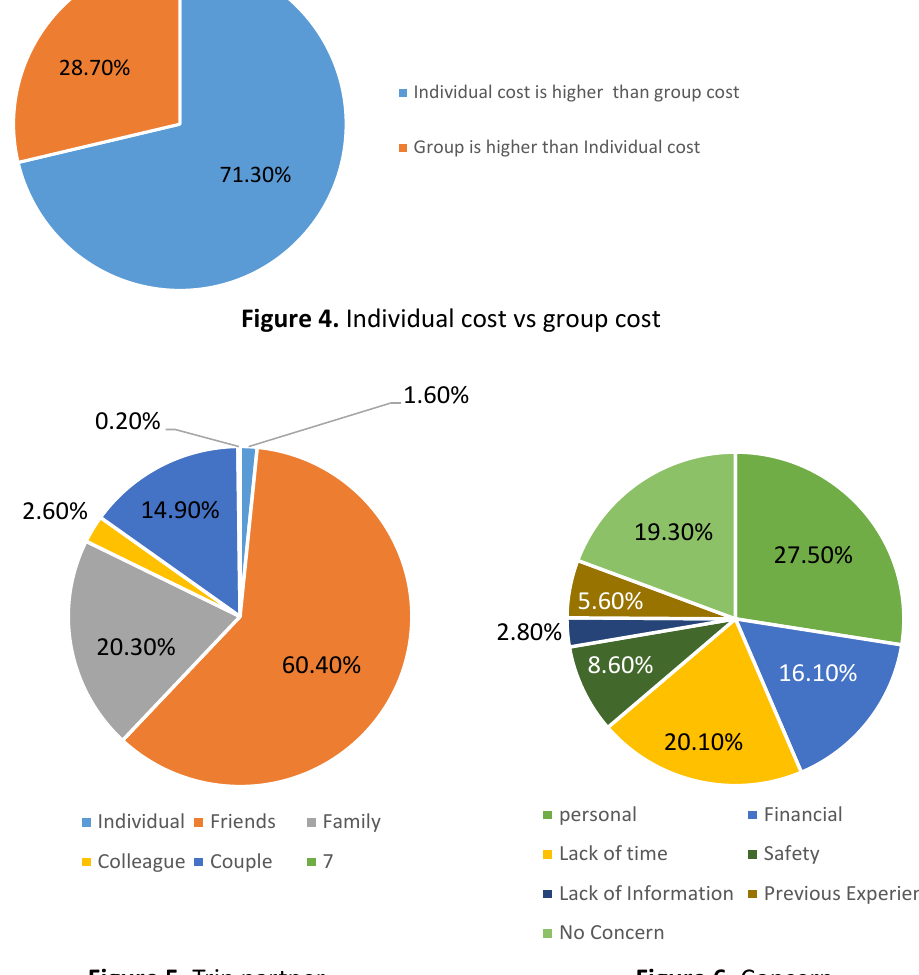
Figure 5. Trip partner Figure 6.